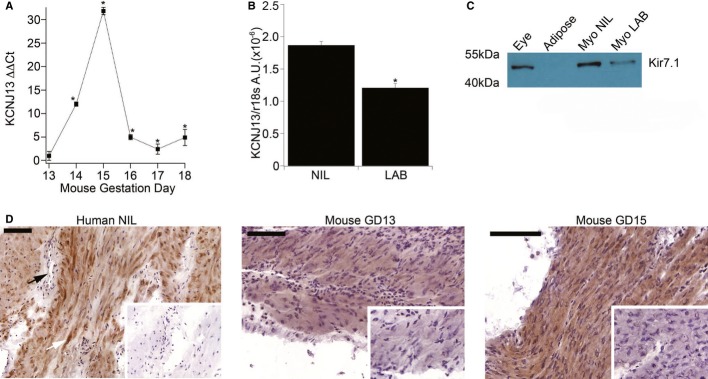
Kir7.1 is expressed in uterine myocytes and is regulated in pregnancy in mice and humansmRNA expression of Kcnj13 in mice (n = 5; mean ± SD, per GD) normalized to GD13. *P < 0.05, Student's t-test.mRNA expression of KCNJ13 (plotted as arbitrary units relative to 18s rRNA) in human myometrial samples from women at term not in labour (NIL) and at term in labour (LAB) (n = 8; mean ± SD, per group). *P < 0.05, Student's t-test.Immunoblot of pooled lysates from eye, adipose tissue, NIL and LAB myometrium (n = 4) probed with antibody to human Kir7.1 (full blot available in Supplementary Fig S1).Immunohistochemistry for Kir7.1 in human NIL myometrium (left panel), GD13 murine myometrium (centre panel) and GD15 murine myometrium (right panel). Arrow indicates absence of staining in blood vessel. Inset panels show tissue treated with pre-absorbed primary antibody control counterstained with haematoxylin. Scale bar = 100 μm.